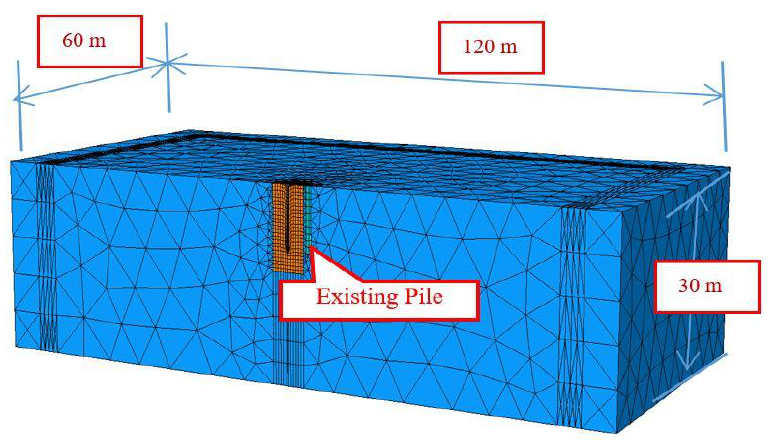
Figure 2. Two-dimensional section of the model.